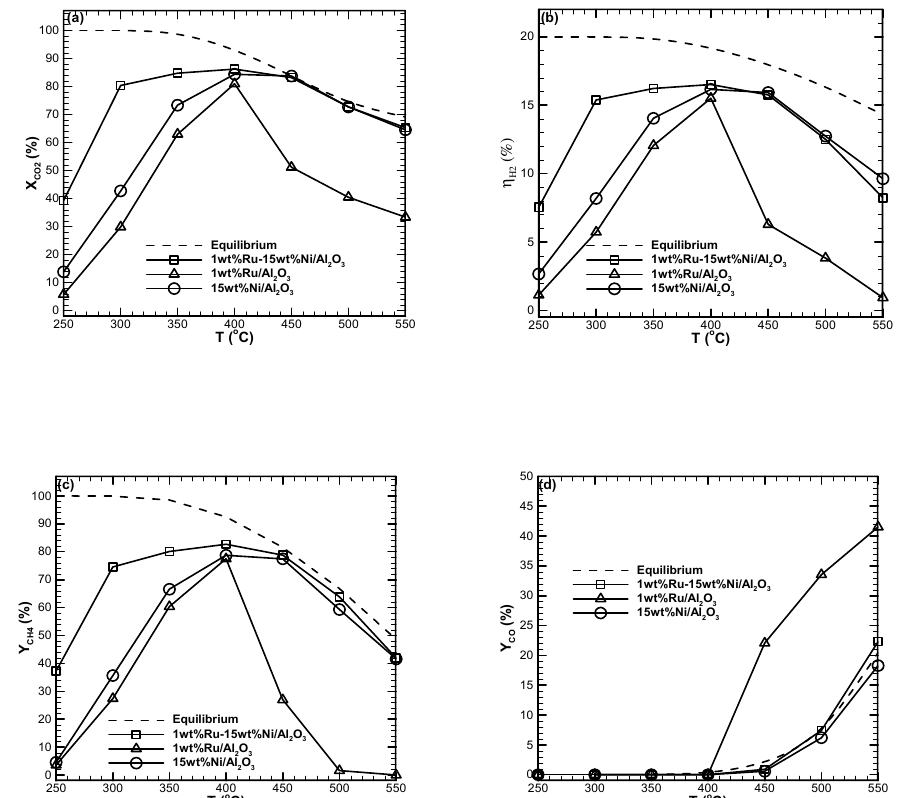
Figure 7. Averaged CO 2 methanation performance as a function of temperature using 1 wt% Ru-15 wt% Ni/Al 2 O 3 catalyst based on time on stream measurement. ( a ) CO 2 conversion, ( b ) H 2 efficiency, ( c ) CH 4 yield, and ( d ) CO yield.